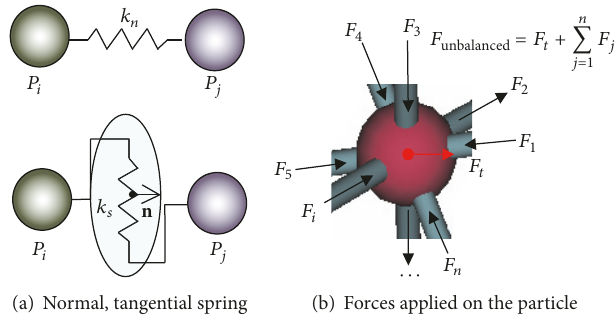
Figure 8: Particles and spring ligament.